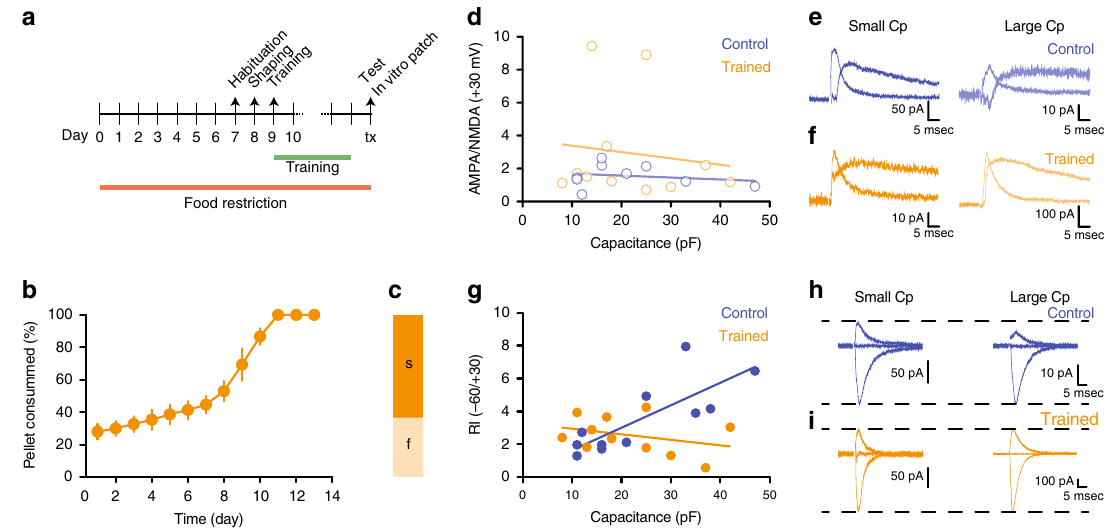
Fig. 2 Motor training induces plasticity on excitatory synapses. a Experimental design for plasticity experiments after SPRT. b Pellets consumed during the training. c Performance on the test day. d – f AMPA/NMDA ratio vs cell capacitance ( n = 9 – 11 cells/group) ( d ), with corresponding example traces in e and f . g – i Recti fi cation index vs cell capacitance ( n = 11 cells/group) ( g ) and representative traces in h and i . All data are reported as mean and SEM. Results obtained from control mice are displayed in blue whereas data obtained from trained mice are shown in orange